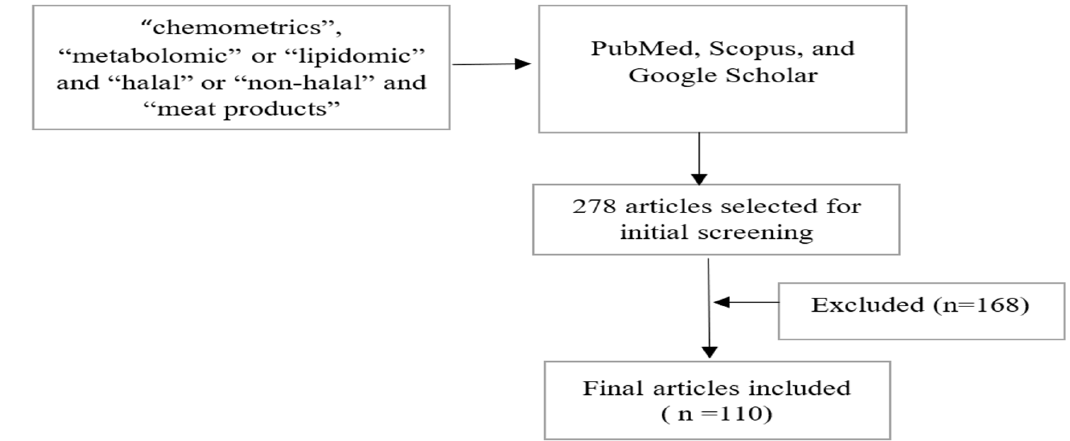
Figure 4. Flowchart of methodology.